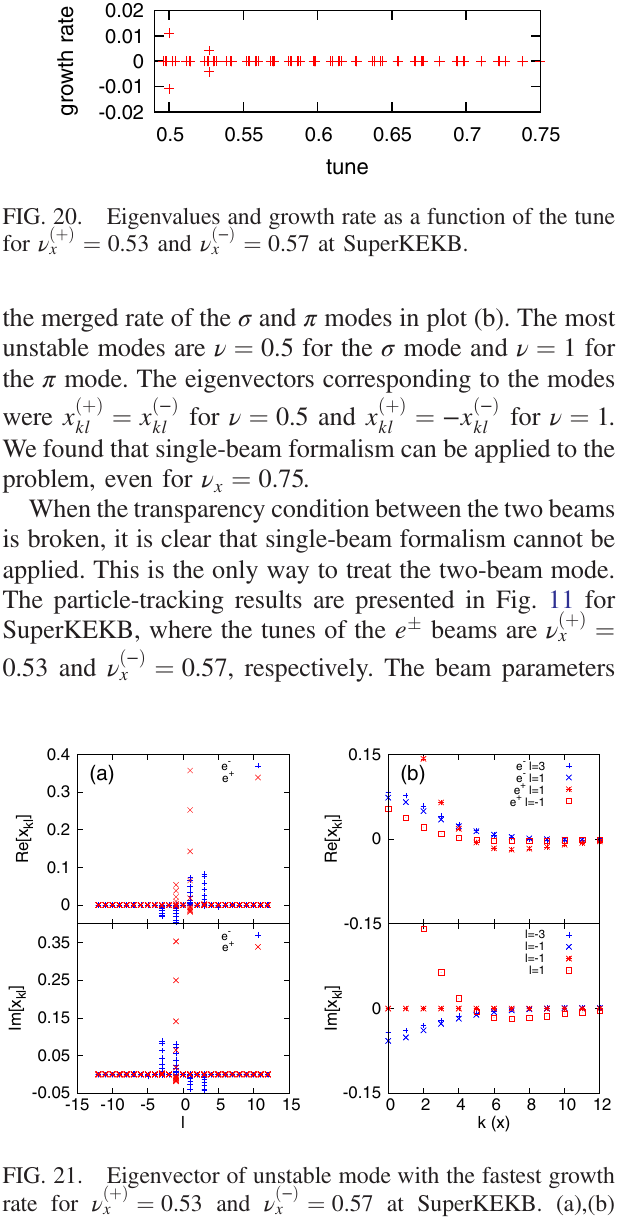
FIG. 19. Eigenvalues and growth rate as a function of the tune for the two-beam mode at ν in the absolute, where ξ (a) Two-beam mode and (b) single-beam mode with the assumption of a σ or π mode.